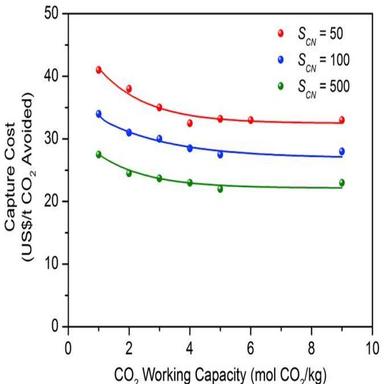
Relationship between the costs of C-capture, CO2 selectivity, and working capacity for solid physisorbents.